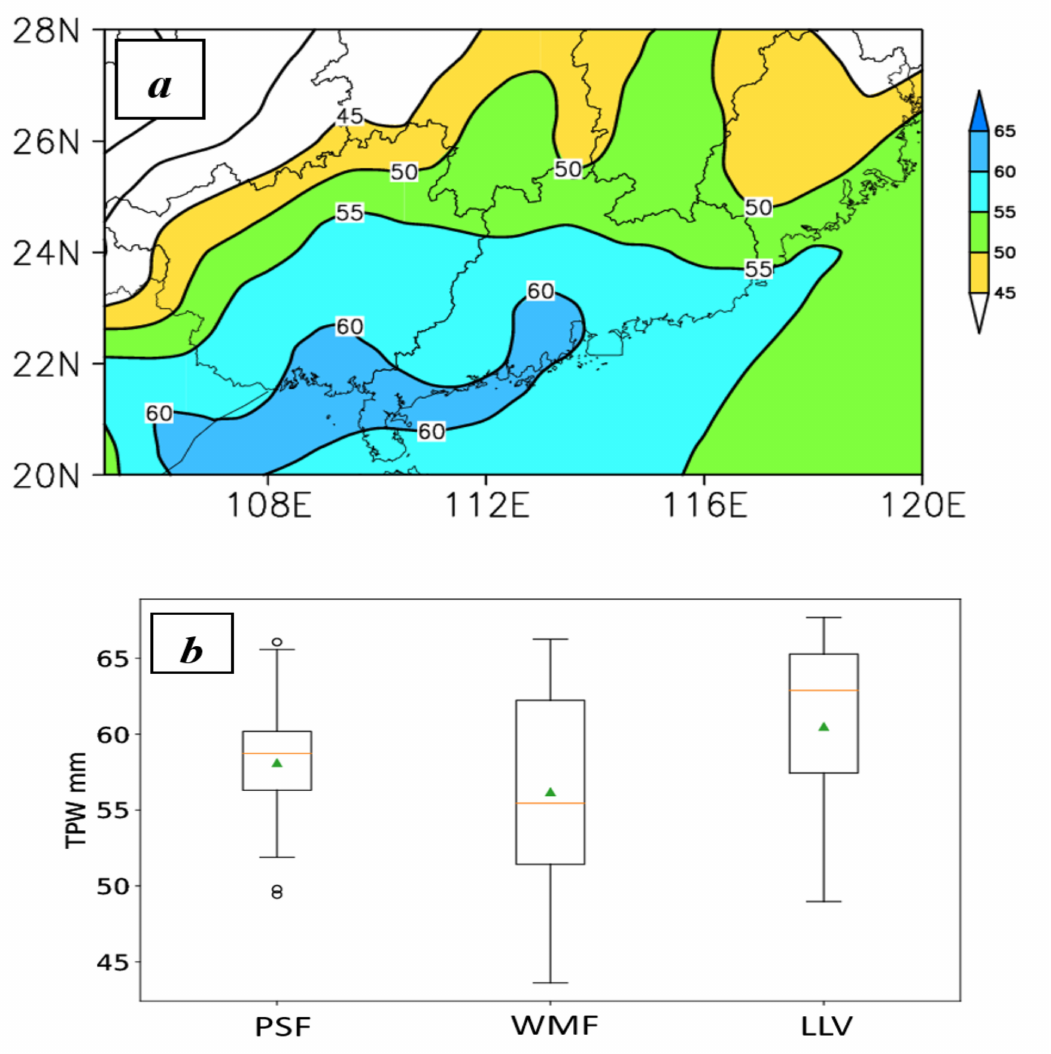
Figure 11. ( a ) Distribution of the daily (at 0800 BST) mean PWAT (mm) that is averaged for the 58 WSHR events under study; and ( b ) the box-whisker plots of the PWAT distribution, taken at the Yangjiang Station, for each type of WSHR